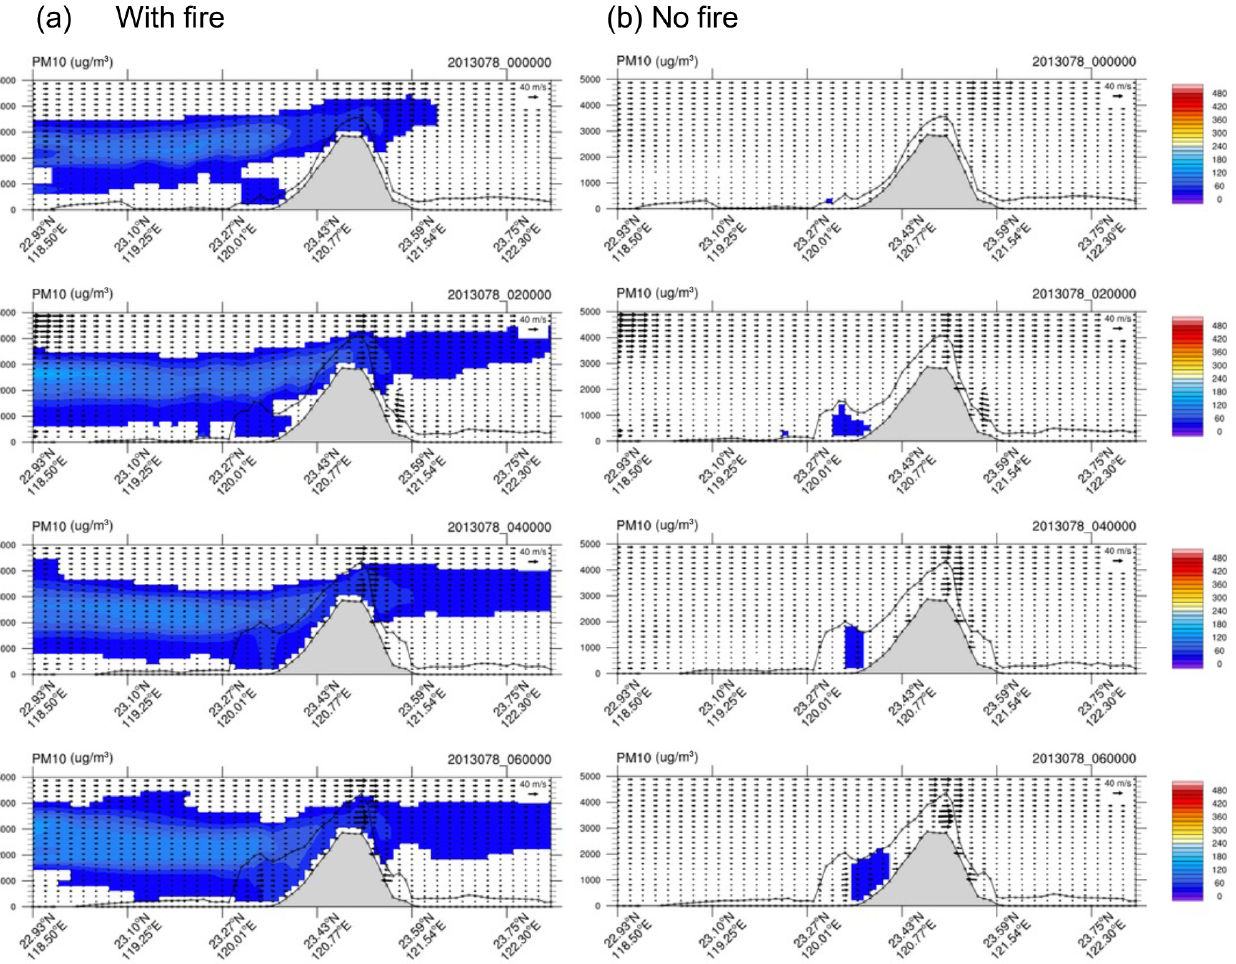
Figure 11. Similar to Fig. 10 but on 19 March 2013 at 08:00, 10:00, 12:00 and 14:00LST (a) with fire and (b) with no fire.